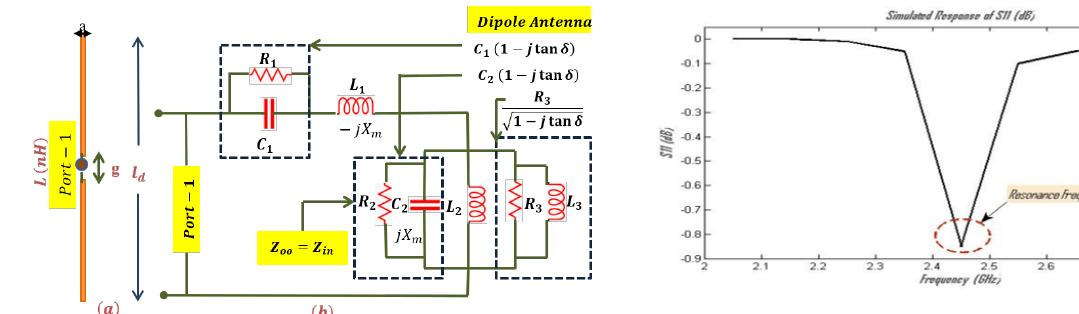
Fig. 7. The simulated response of S 11 ( dB ) for 0.11 λ 0 dipole antenna ( α = λ 0 /800 ) , ( g = λ 0 /100 ) with in- ductor of ( L = 100 nH ) at resonant frequency of 2.45